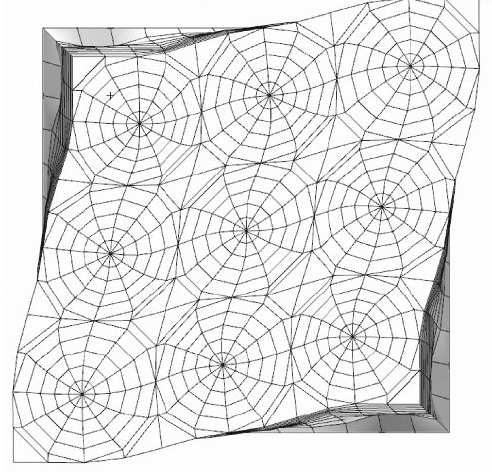
Fig. 28. 4th mode: − 995 Hz X, Z Symmetric translation (1177 Hz –